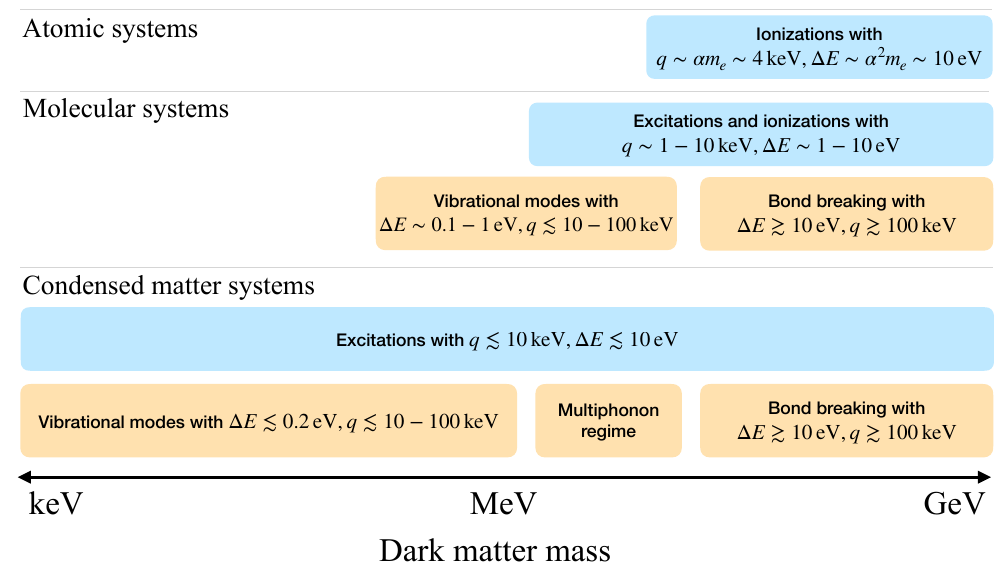
Figure 2: For various bound systems, we indicate some possible excitation modes in the system, some typical ( q , ω ∼ ∆ E ) where they give a large response, and the cor- responding range of DM masses which are well-matched to that system. Blue shaded boxes indicate electronic excitations, while orange shaded boxes indicate modes that can be excited by a DM-nucleus coupling. For electronic excitations in condensed matter systems, different materials will have ideal response to different ranges of DM masses, so the shaded region just indicates that there exist known systems that have been studied for the whole mass range. For these lectures, we will focus on spin-independent DM interactions with electrons and / or nuclei. For spin-dependent interactions, other excitation modes and response functions can be